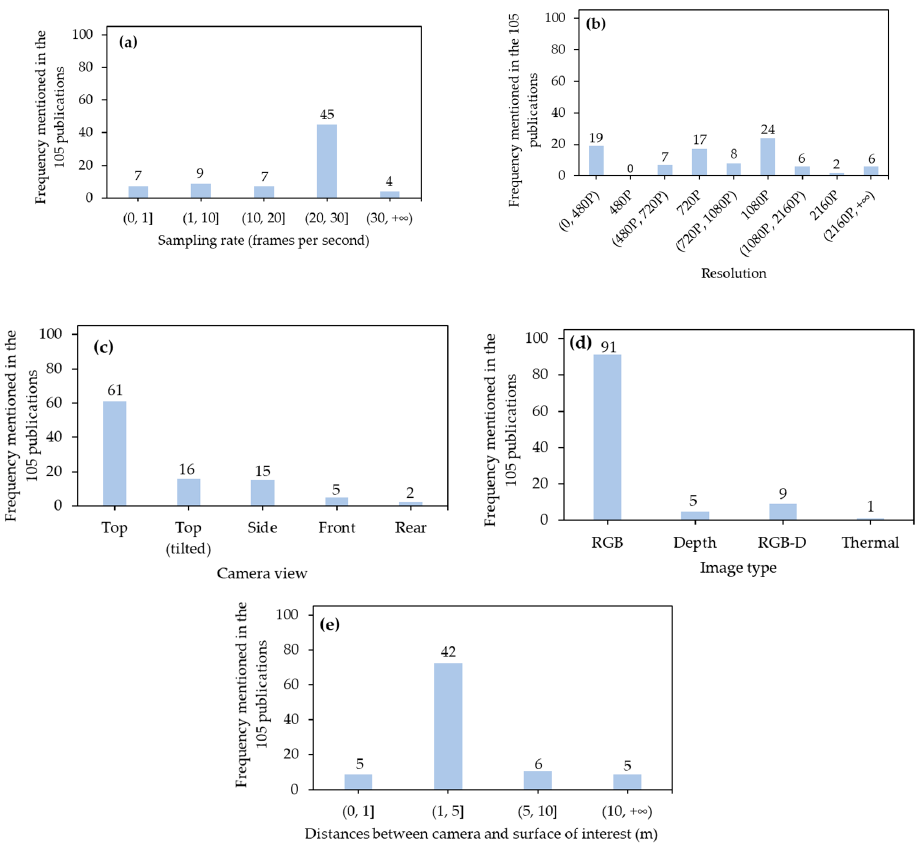
Figure 5. Frequency mentioned in the 105 publications corresponding to different camera settings: ( a ) sampling rate; ( b ) resolution; ( c ) camera view; ( d ) image type; and ( e ) distances between camera and surface of interest. ( a , b , d ): number near a round bracket is not included in specific ranges while number near square bracket is. ( b ): 480P is 720 × 480 pixels, 720P is 1280 × 720 pixels, 1080P is 1920 × 1080 pixels, and 2160P is 3840 × 2160 pixels. ( d ): RGB is red, green, and blue; and RGB-D is RGB and Depth.